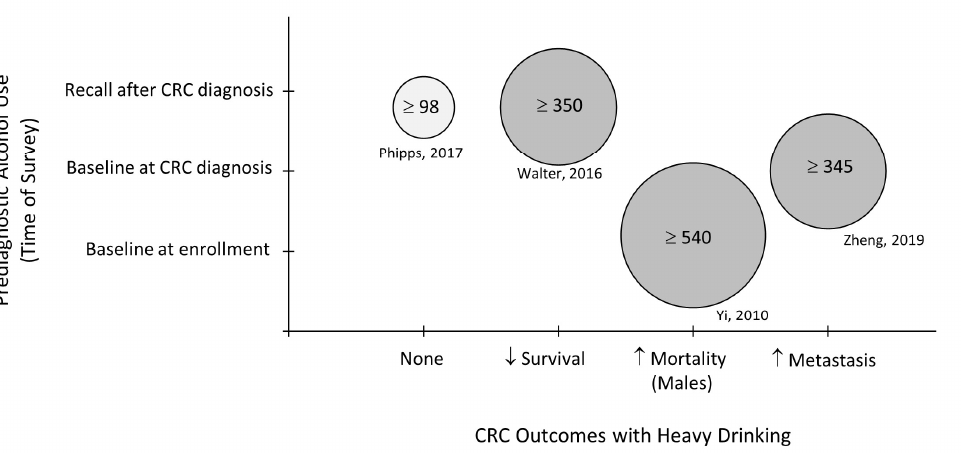
Figure 4. Bubble plot of studies reporting the type of alcohol beverage consumed by prediagnostic timeline and outcomes associated with heavy drinking. Bubble size reflects the noted quantity of alcohol (grams/week) that was designated as heavy drinking in each study [12,16,19,22]. CRC: colorectal cancer.